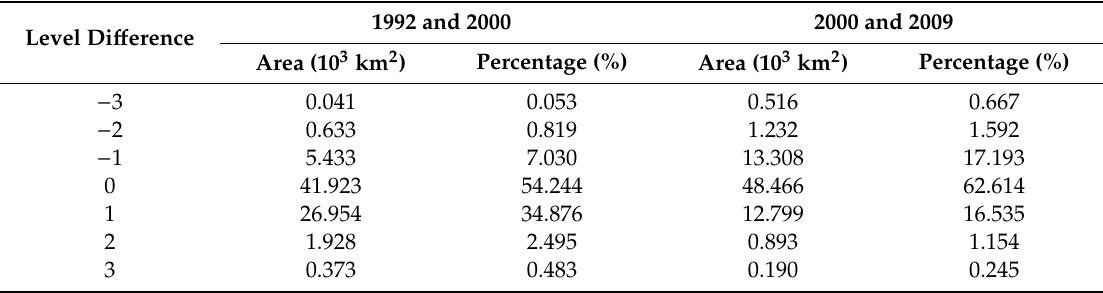
Table 6. Di ff erences in the assessment